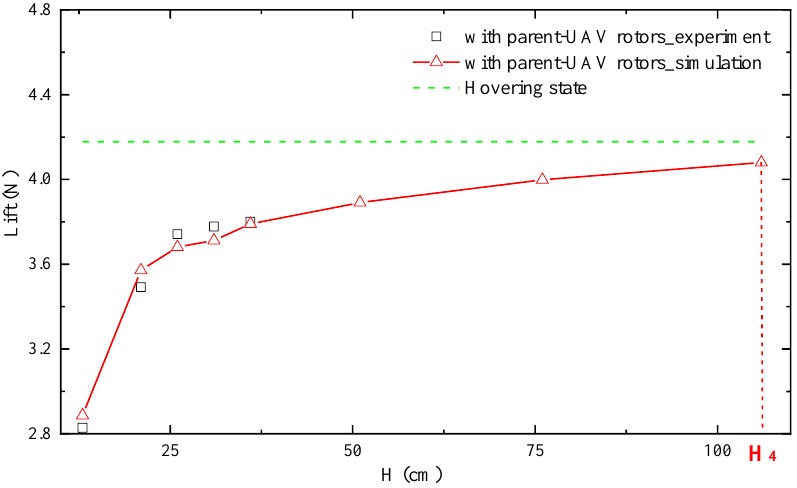
Figure 11. The lift/power of the child UAV in the body interference area. When the child UAV is located right above the parent UAV rotors, it is mainly affected by the rotors. The pressure below the child UAV is lower than that above, reducing the lift of the child UAV. Figure 12 shows the lift curve of the child UAV in the interference area above a parent- rotor. The lift of the child UAV decreases rapidly with the increase in relative height. In this study, the maximum loss of lift is about 31%, corresponding to a relative height of 13 cm. When H = 106 cm (4.64 times Rp), the effect of downwash flow on the lift is less than 3.5%. The simulation results are in good agreement with the experimental results, with an error of less than 10%.